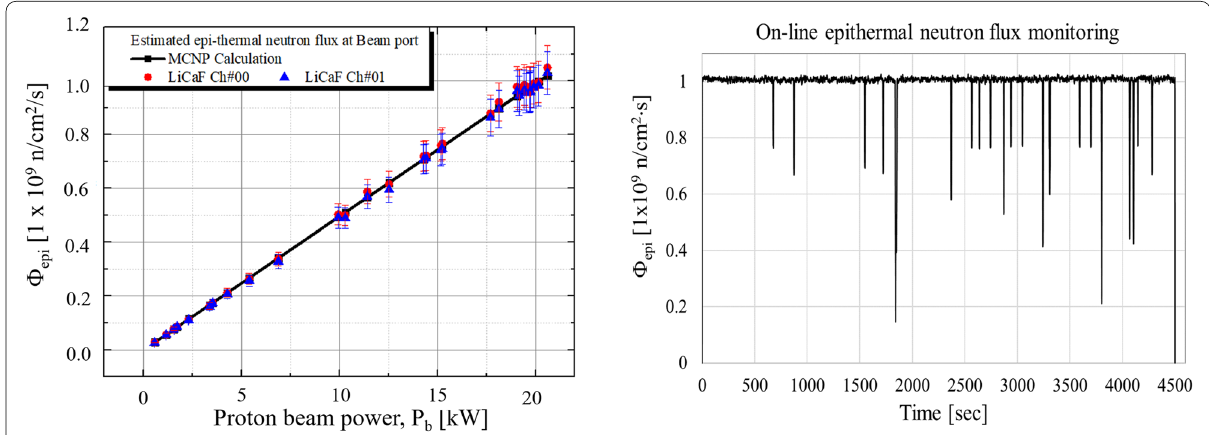
Fig. 21 (Left) Epithermal neutron flux as a function of proton beam power and (right) real‑time epithermal neutron flux monitoring during a 75‑min irradiation test at 20 kW beam power (10 MeV and 2